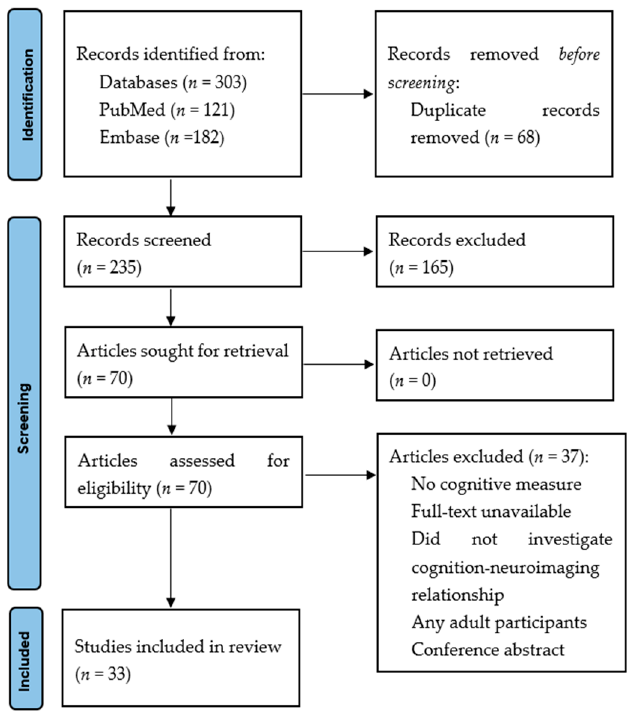
Figure 2. Preferred Reporting Items for Systematic Reviews and Meta-Analyses (PRISMA) flow di- agram.